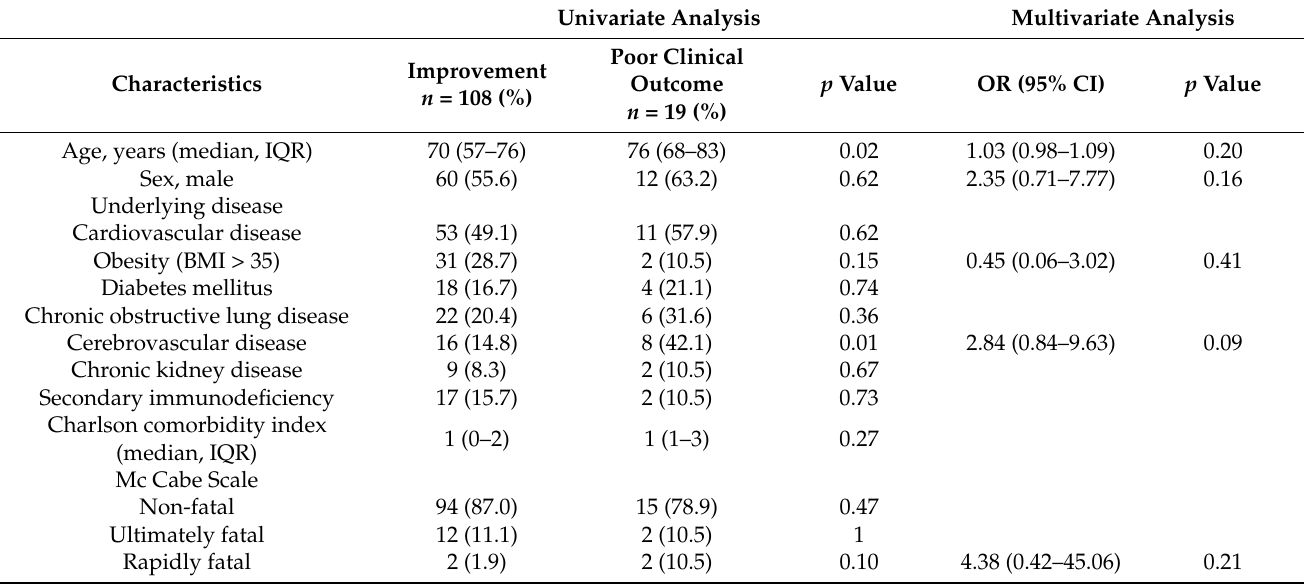
Table 3. Univariate and multivariate analysis of factors associated with poor clinical